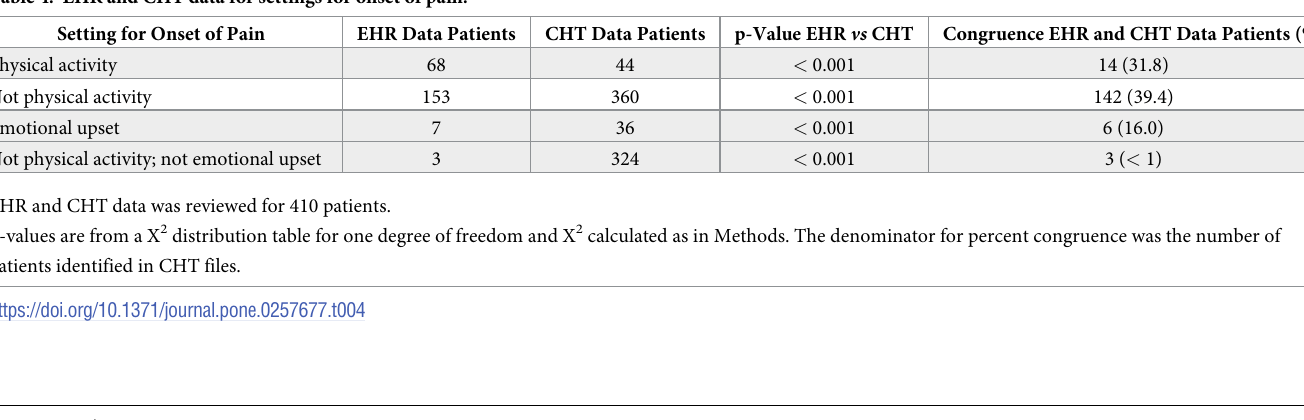
before presentation, during CHT; 8 of 53 patients cited in EHRs with two or more episodes of pain reported constant pain during CHT (Table 5). There was no significant difference for EHR and CHT data for < 2 episodes of pain. But lack of congruence between EHR and CHT data for < 2 episodes of pain was significant with a p-value of < 0.001, Data for the frequency Table 4. EHR and CHT data for settings for onset of pain.